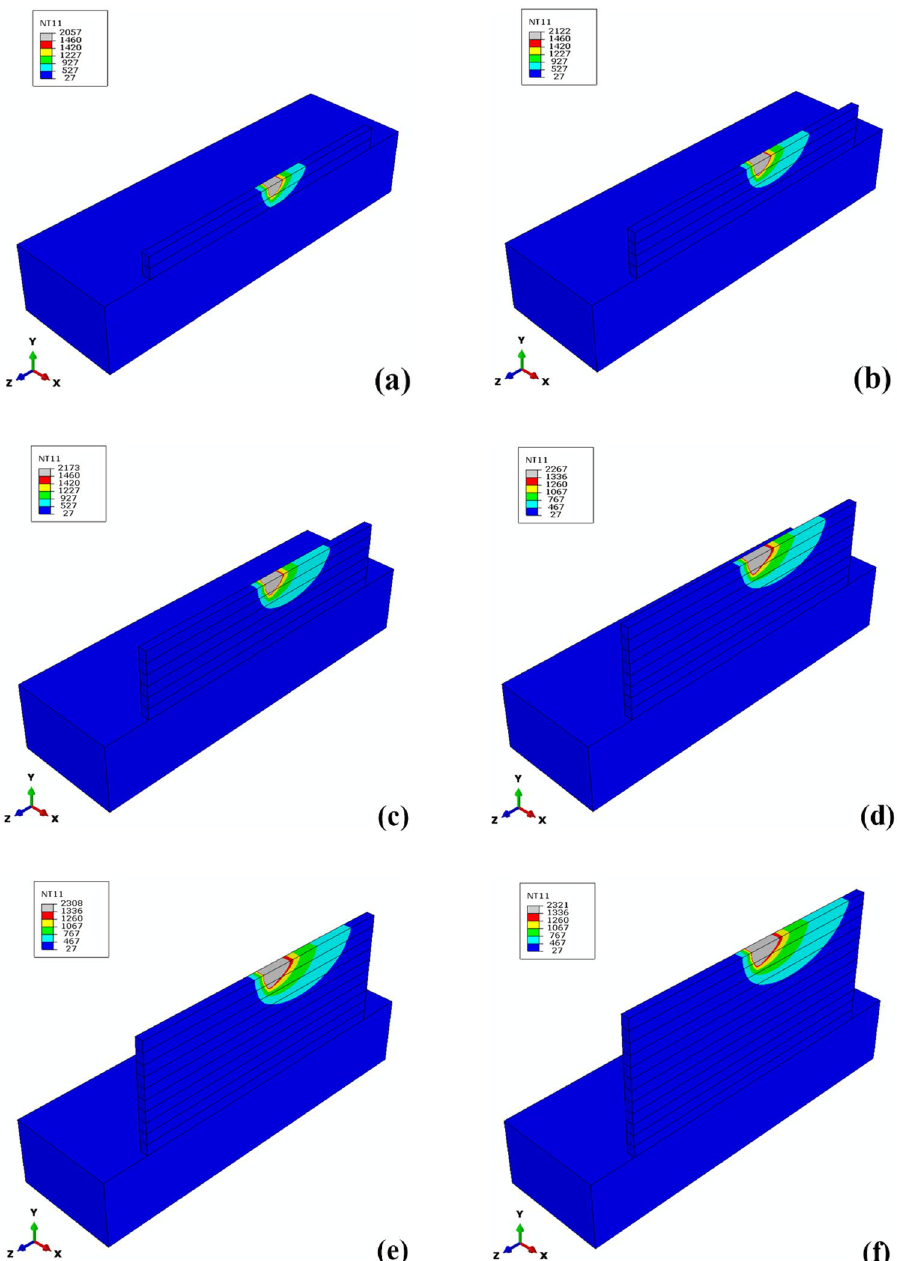
Figure 6. Temperature field ( ℃ ) and the simulated melt pool (gray zone) in the mid-length of layers ( a ) 2, ( b ) 4, ( c ) 6, ( d ) 8, ( e ) 10, and ( f )